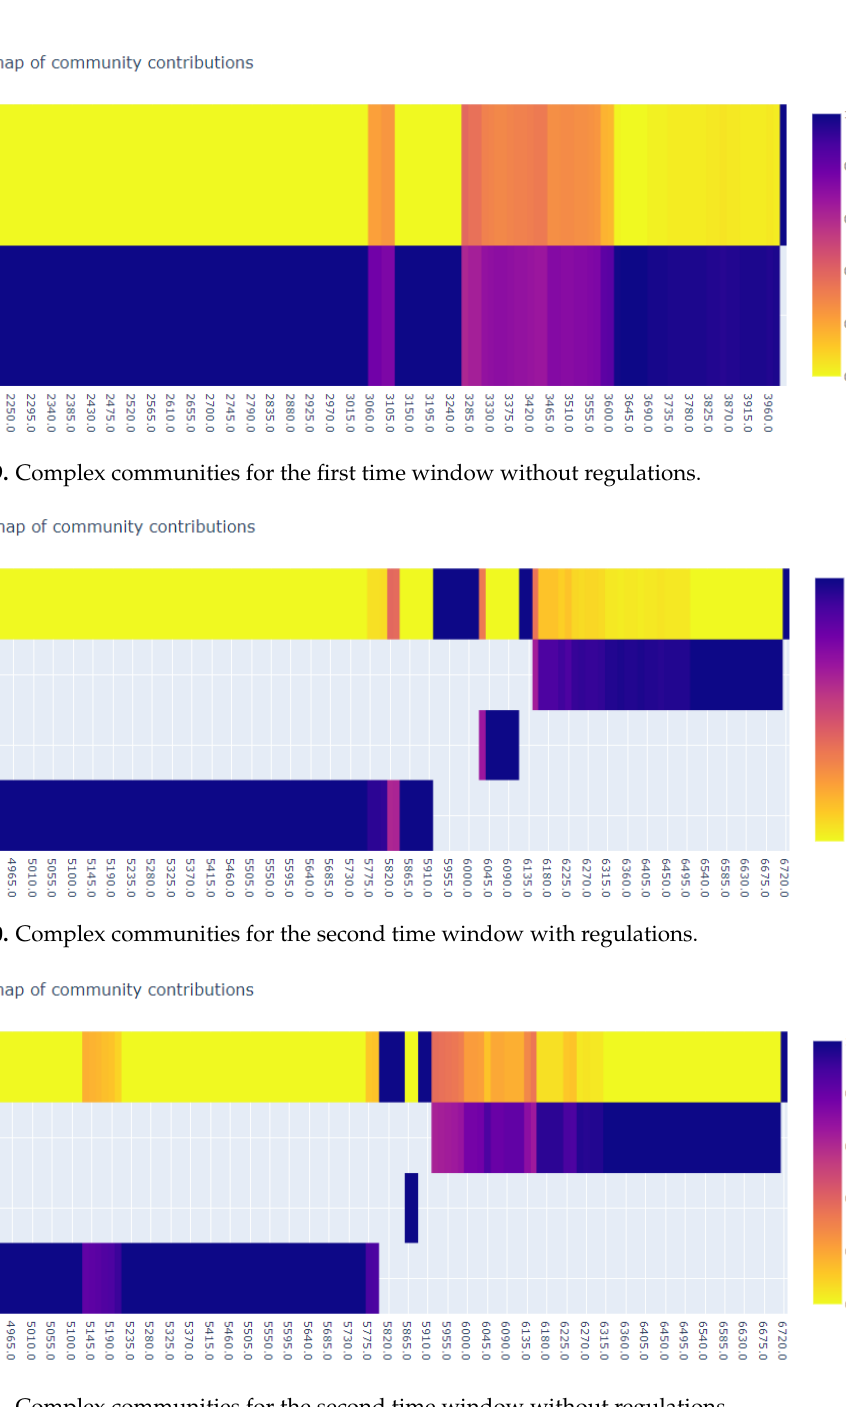
Figure 21. Complex communities for the second time window without